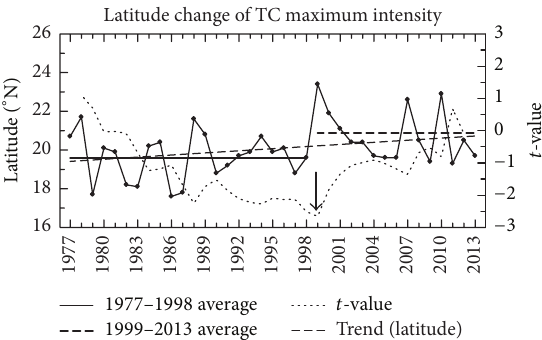
Figure 1: Time series of latitude of tropical cyclone (TC) maximum intensity averaged for all TCs in each year (solid line with dot) and its trend (light face dashed line). Thick solid and bold dashed lines denote averages for 1977–1998 and for 1999–2013, respectively. Arrowdenoteschange-pointyearintimeseriesoflatitudeoftropical cyclone (TC) maximum